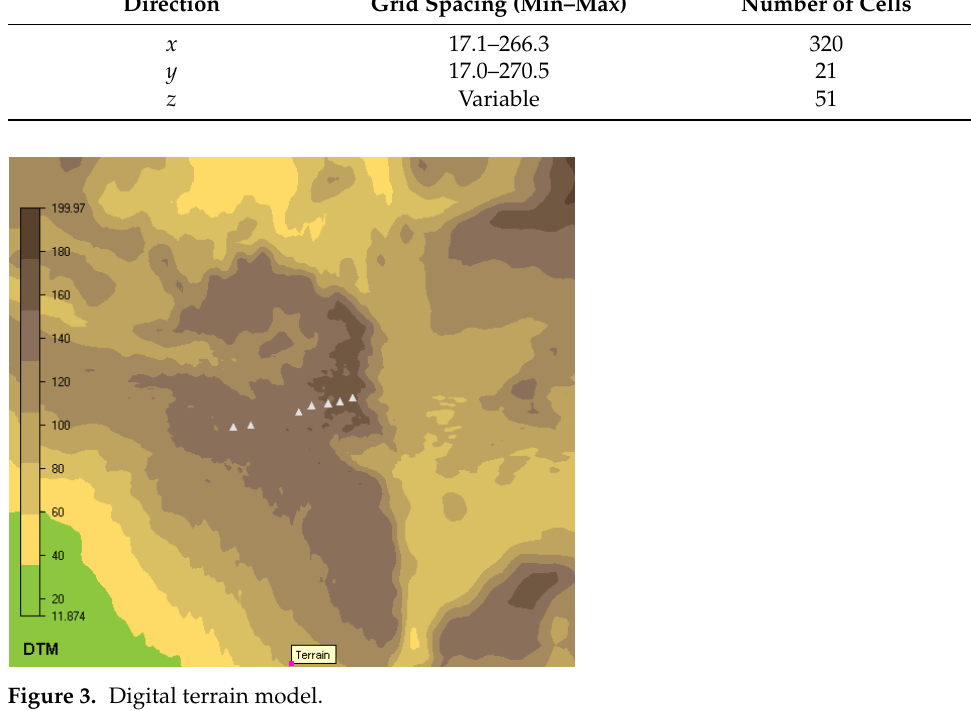
Figure 3. Digital terrain model.